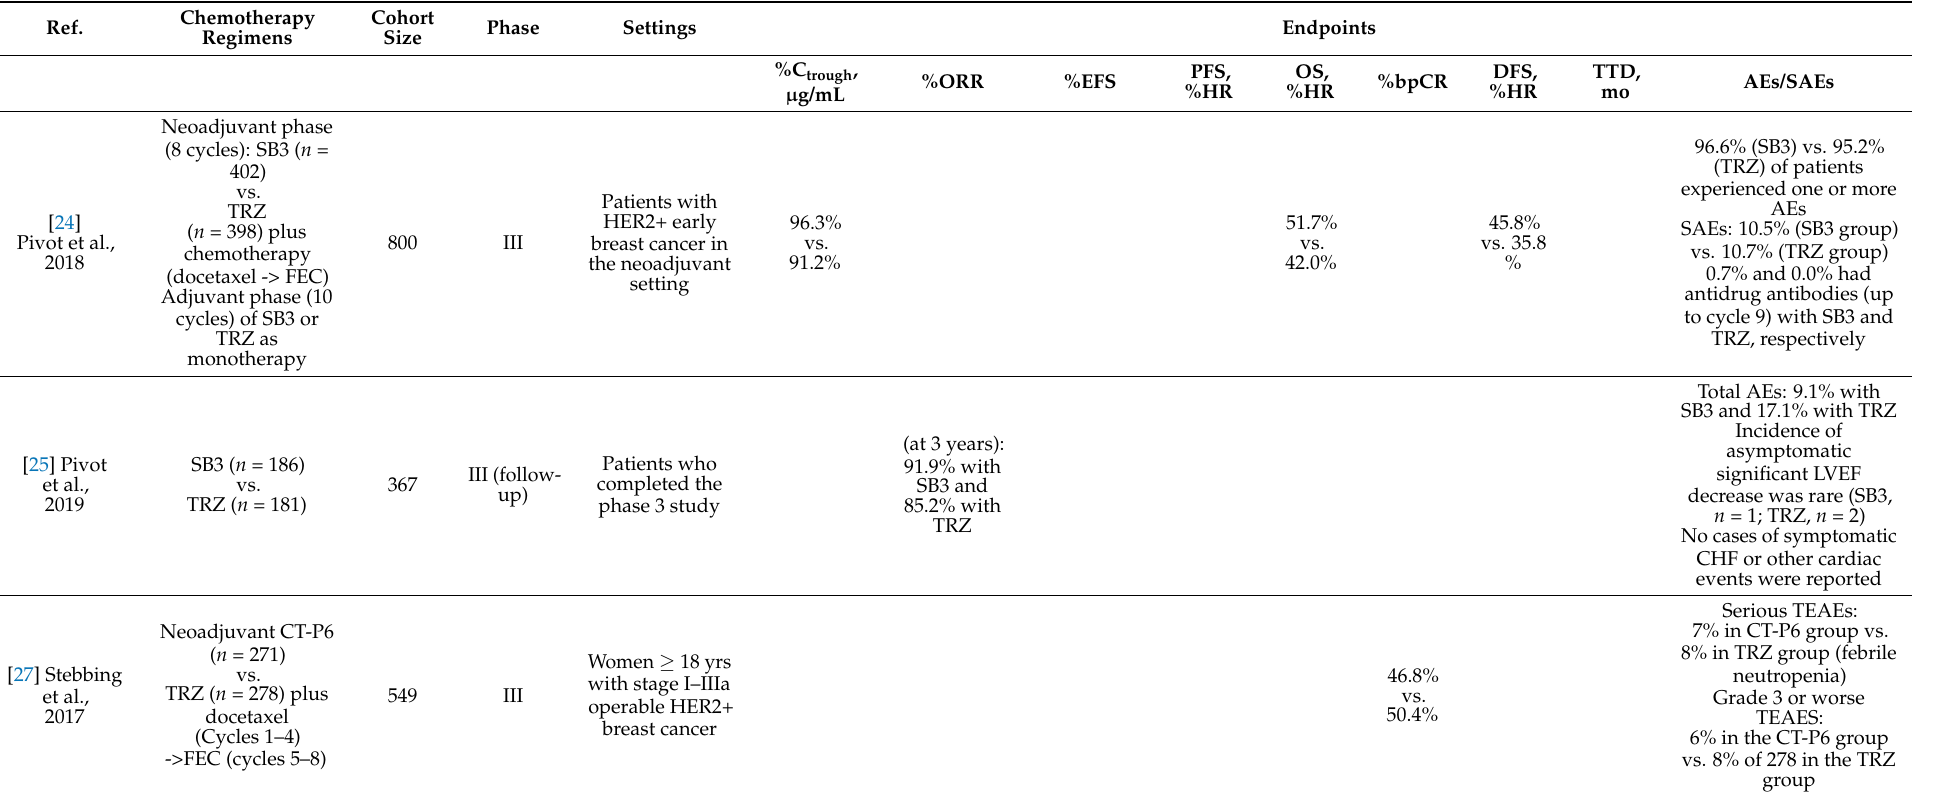
Table 5. Summary of clinical trials evaluating the safety and efficacy of approved trastuzumab biosimilars in patients with HER2+ breast cancer.